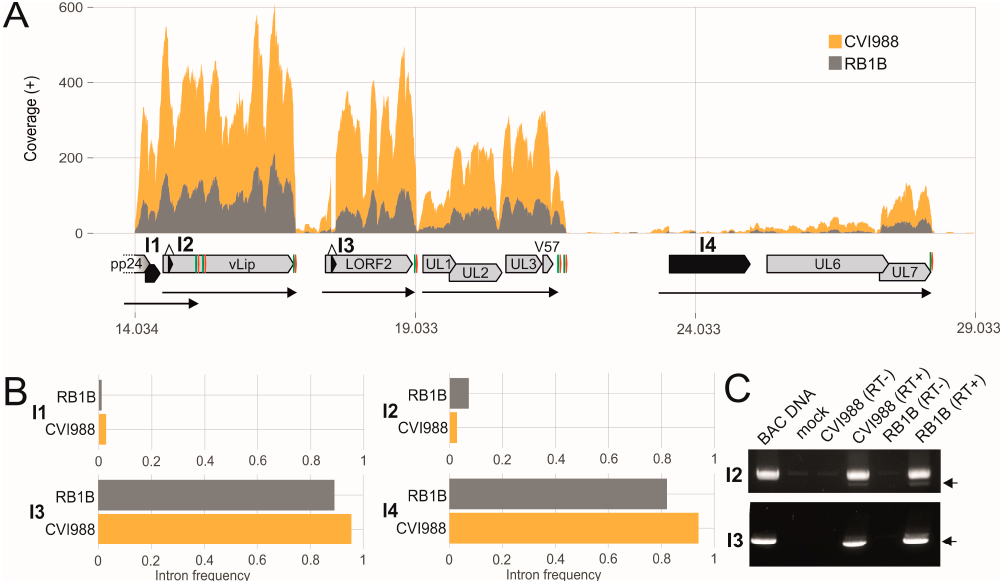
Figure 3. The Marek’s disease virus (MDV) unique long (U L ) region. ( A ) Visualization of RNA-Seq coverage across parts of the MDV U L region with respective introns in black. Green and red arrows indicate the polyadenylation signal and the poly(A) cleavage site respectively. Underlying black arrows suggest unspliced (mono-, bi-, or polycistronic) mRNAs. ( B ) Comparison of intron frequencies in RB1B and CVI988 infected primary chicken B cells. I1: pp24, I2: vLIP, I3: LORF2 (MDV012), I4: transcript antisense to UL5 (MDV017). ( C ) RT-PCR was performed to validate the splicing event. PCR products were derived using forward/reverse primers to amplify the respective intron-flanking regions. The representative gel images illustrate the results of RT-PCR analysis. The black arrows indicate the spliced form of the respective gene.